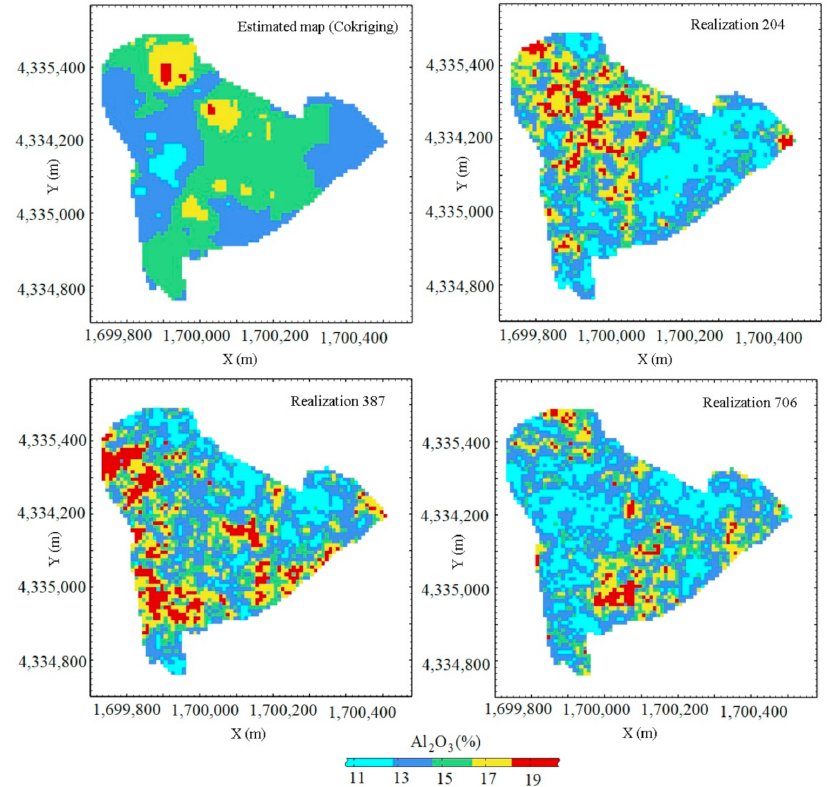
Figure 11. Scatter plots of validation samples (real values) and estimation and simulation results (the best three selected realizations). Red lines represent identity, while blue lines are regressions.